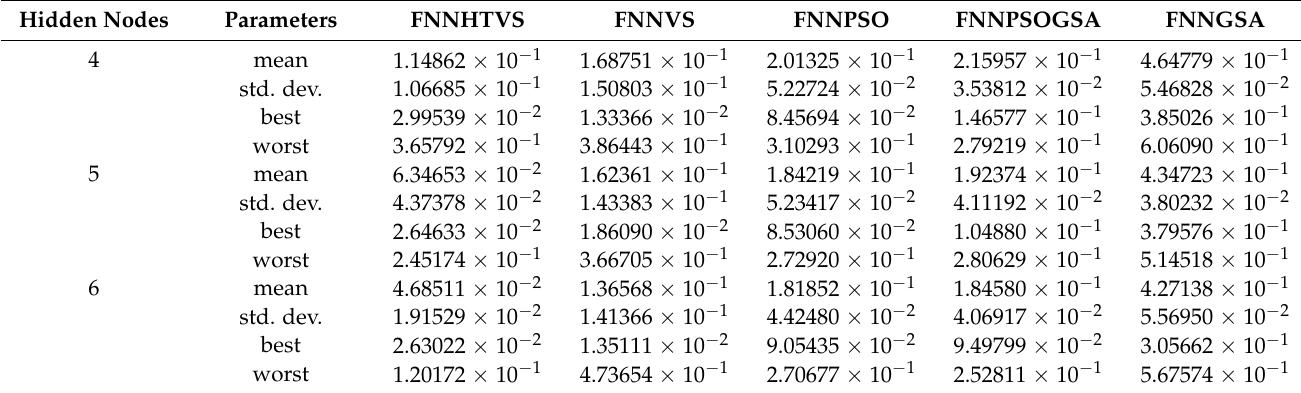
Table A2. Statistical results (MSE) in the iris classification